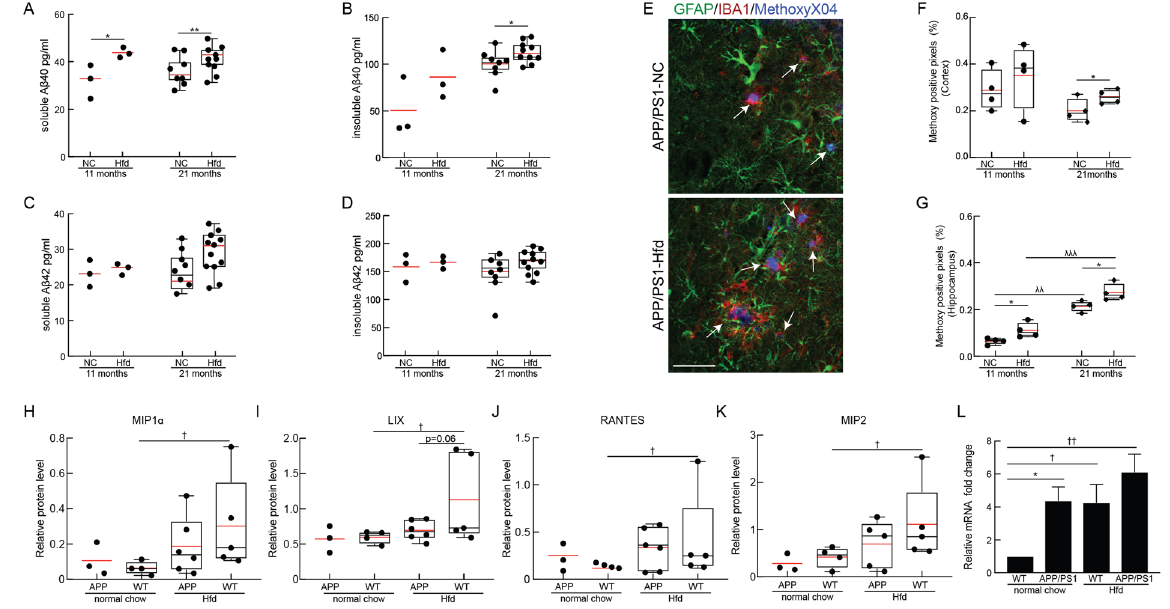
Figure 2. Immunohistochemical and molecular analysis of brain tissue of APP/PS1 and WT mice fed a Hfd or normal chow. PBS-soluble fraction of Aß40 ( A ) and Aß42 ( C ) monomeric species and formic acid-soluble fraction of Aß40 (B) and Aß42 ( D ) monomeric species, measured using ELISA from the brains of APP/ PS1 mice on Hfd (started at 4 months of age) or normal chow for mice at 11 and 21 months of age. Animal numbers for all measurements — 11 months: APP/PS1-Hfd: n = 3; APP/PS1-NC: n = 3; 21 months: APP/ PS1-Hfd: n = 10; APP/PS1-NC: n = 9); * p < 0.05 and ** p < 0.01; Student’s t-test. ( E ) Representative confocal images of cortical immunostained sections from 21-month old APP/PS1-NC mice on normal chow (top) or Hfd (bottom), stained with MethoxyX04 for amyloid plaques (blue, plaques indicated with white arrows), anti- IBA1 for microglia (red), and anti-GFAP for astrocytes (green). Scale bar = 50 µ m. Percentage of pixels above threshold for Methoxy-X04 in the cortex ( F ) and hippocampus ( G ) for 11 and 21 month old APP/PS1 mice on normal chow and Hfd. Animal numbers for all measurements — 11 months: APP/PS1-NC: n = 3; WT-NC: n = 3; APP/PS1-Hfd: n = 3; WT-Hfd: n = 4; 21 months: APP/PS1-NC: n = 4; WT-NC: n = 4; APP/PS1-Hfd: n = 4; WT-Hfd: n = 3; * p < 0.05 between genotypes (APP/PS1 vs. WT); λ p < 0.05, λλ p < 0.01, and λλλ p < 0.001 between animal ages; Student’s t-test. Relative protein levels of ( H ) Macrophage inflammatory protein 1 alpha (MIP1 α ) ( I ) CXCL5 (LIX) ( J ) CCL5 (RANTES) and ( K ) CXCL2 (MIP2) for APP/PS1 and WT mice on normal chow or Hfd at 21 months of age. Animal numbers for all measurements — APP/PS1-NC: n = 3; WT-NC: n = 4; APP/PS1-Hfd: n = 5; WT-Hfd: n = 5; † p < 0.05 between diets (Hfd vs. NC); one-way ANOVA with post-hoc pair-wise comparisons using Dunn’s multiple comparison correction. ( L ) Expression of endogenous murine APP mRNA from brain tissue of APP/PS1 and WT mice on a Hfd or normal chow at 21 months of age, normalized to GAPDH mRNA levels. Animal numbers for all measurements — APP/PS1-NC: n = 4; WT- NC: n = 3; APP/PS1-Hfd: n = 4; WT-Hfd: n = 4); * p < 0.05 between genotypes (APP/PS1 vs. WT); † p < 0.05, ††p < 0.01 between diets (Hfd vs. NC); Student’s